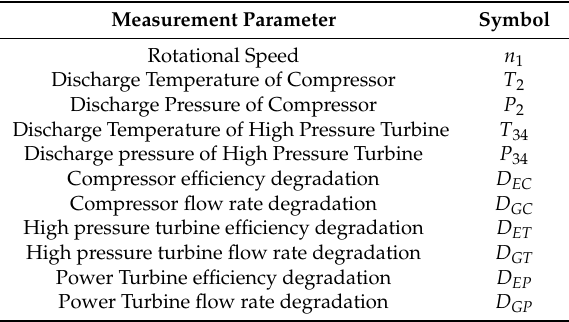
Table 2. Parameter list for this case.